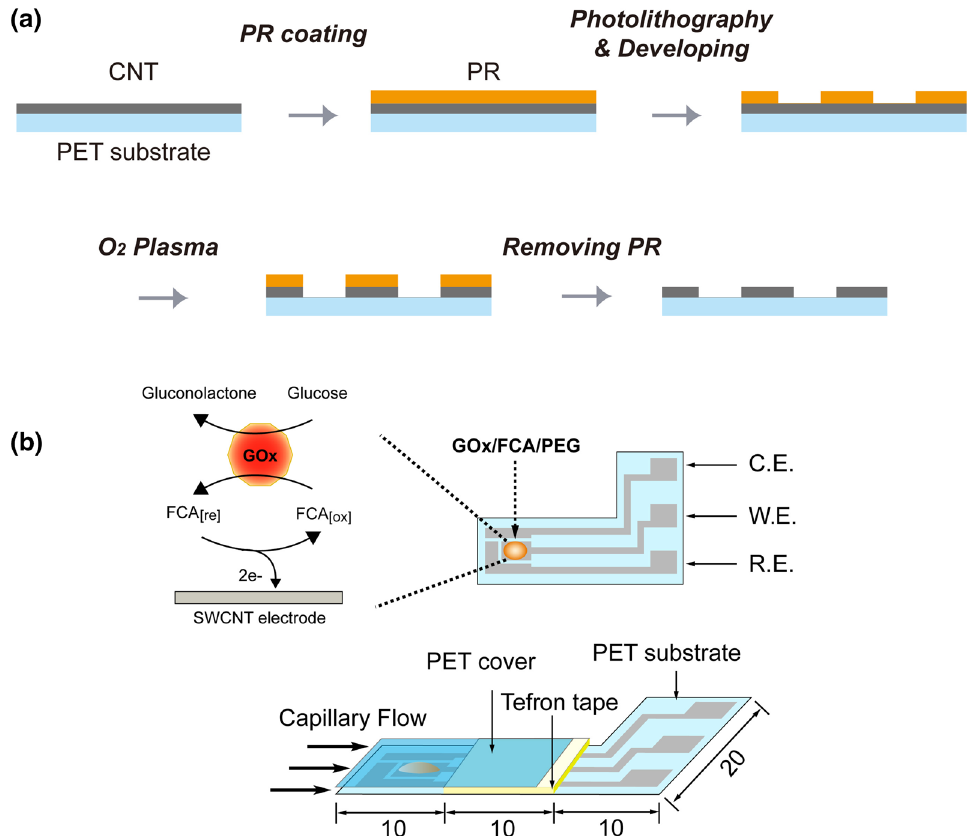
Fig. 1 Schematic diagram of a the fabrication of SWCNT electrodes by O 2 ‑plasma treatment and b the construction of glucose biosensors based on a three SWCNT electrode system. The gap between the PET substrate and hydrophilic cover film produced by Teflon tape allows the capillary addition of a sample with a volume less than 10 μL. Dimensions represent